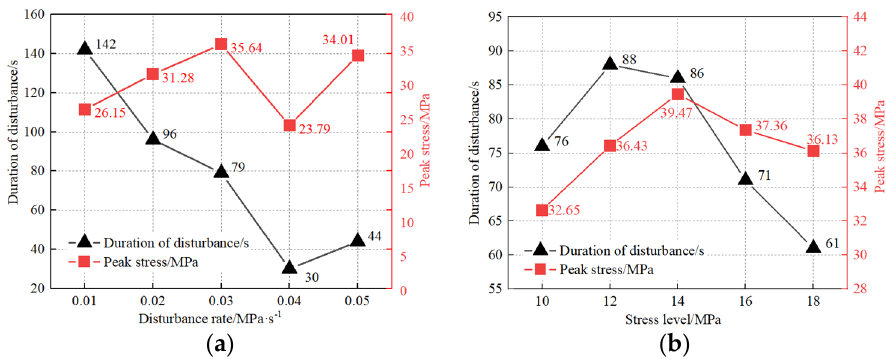
Figure 6. Relationship of control variables and quasi-static stress parameters: ( a ) disturbance rate; ( b ) stress level .